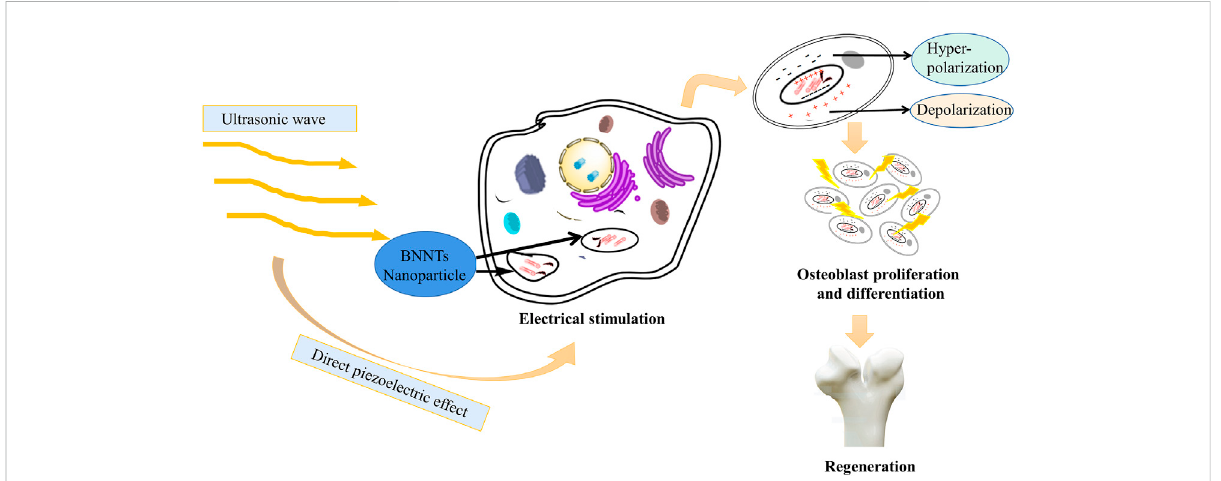
FIGURE 5 BNNTnanoparticlescaninternalizeexternalultrasonicirradiationintoelectricalstimulation.Underthedirectpiezoelectriceffect,ultrasound,as a mechanical stress, is transformed into electrical stimulation and then promotes proliferation and differentiation of osteoblasts (Jacob et al., 2018).